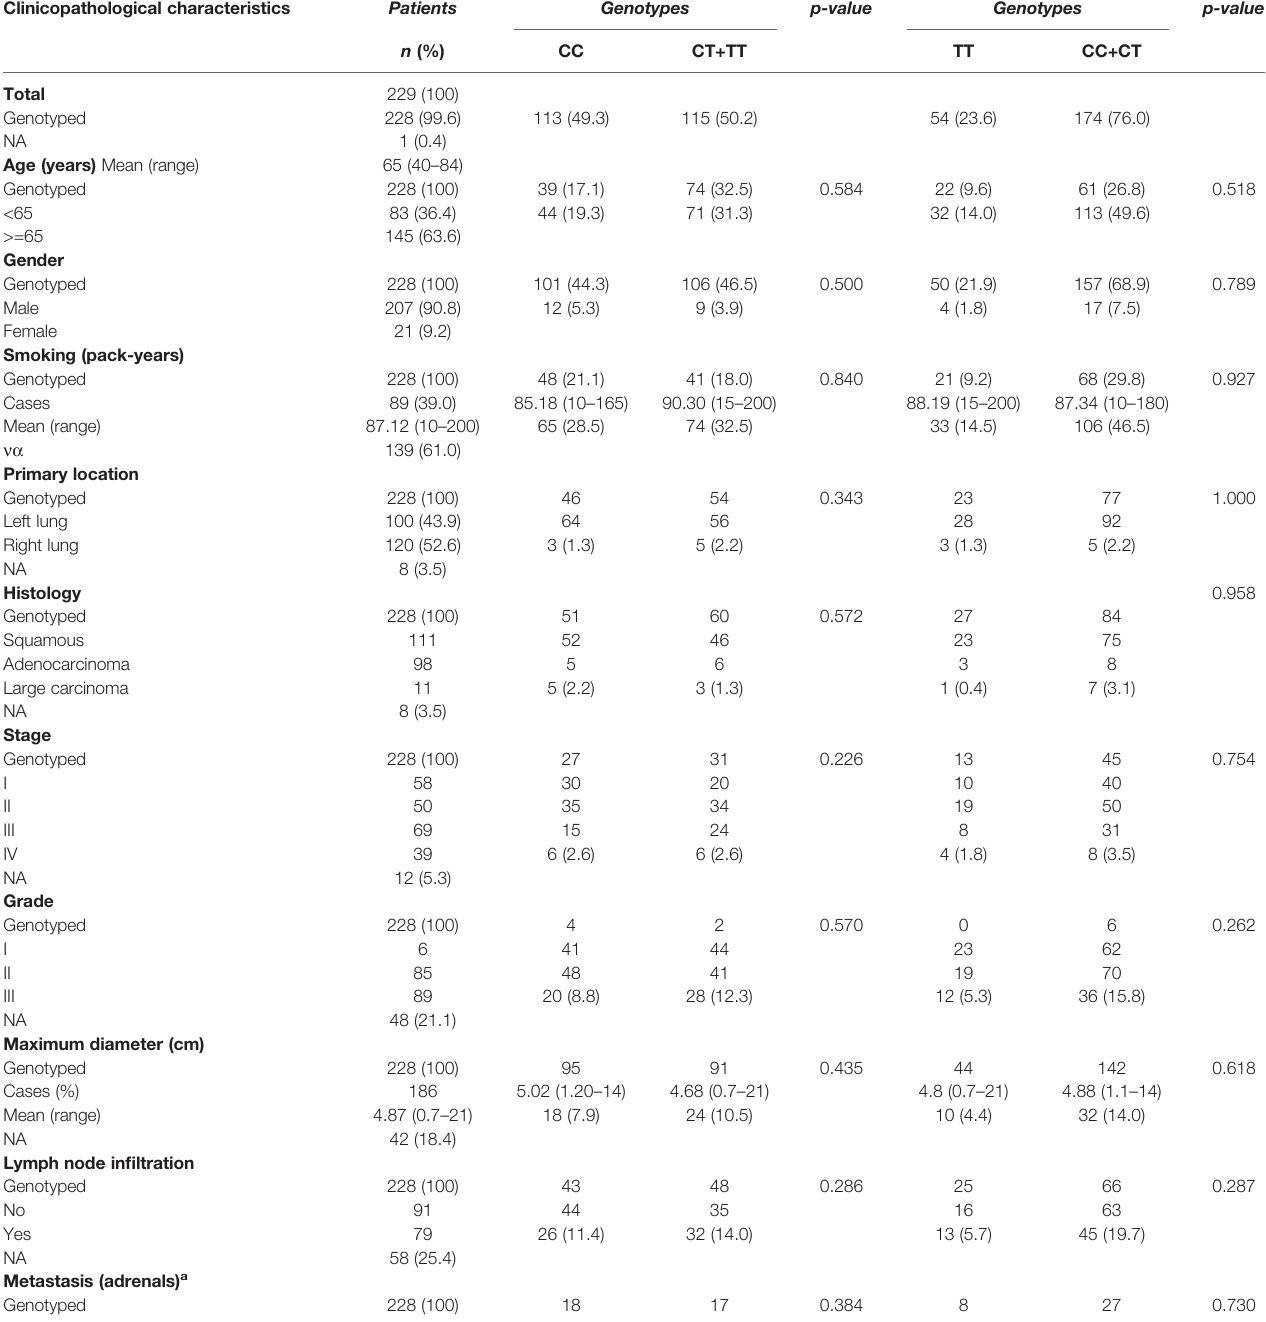
TABLE 6 | Relationships between clinicopathological variables of NSCLC patients and CD40 rs1883832